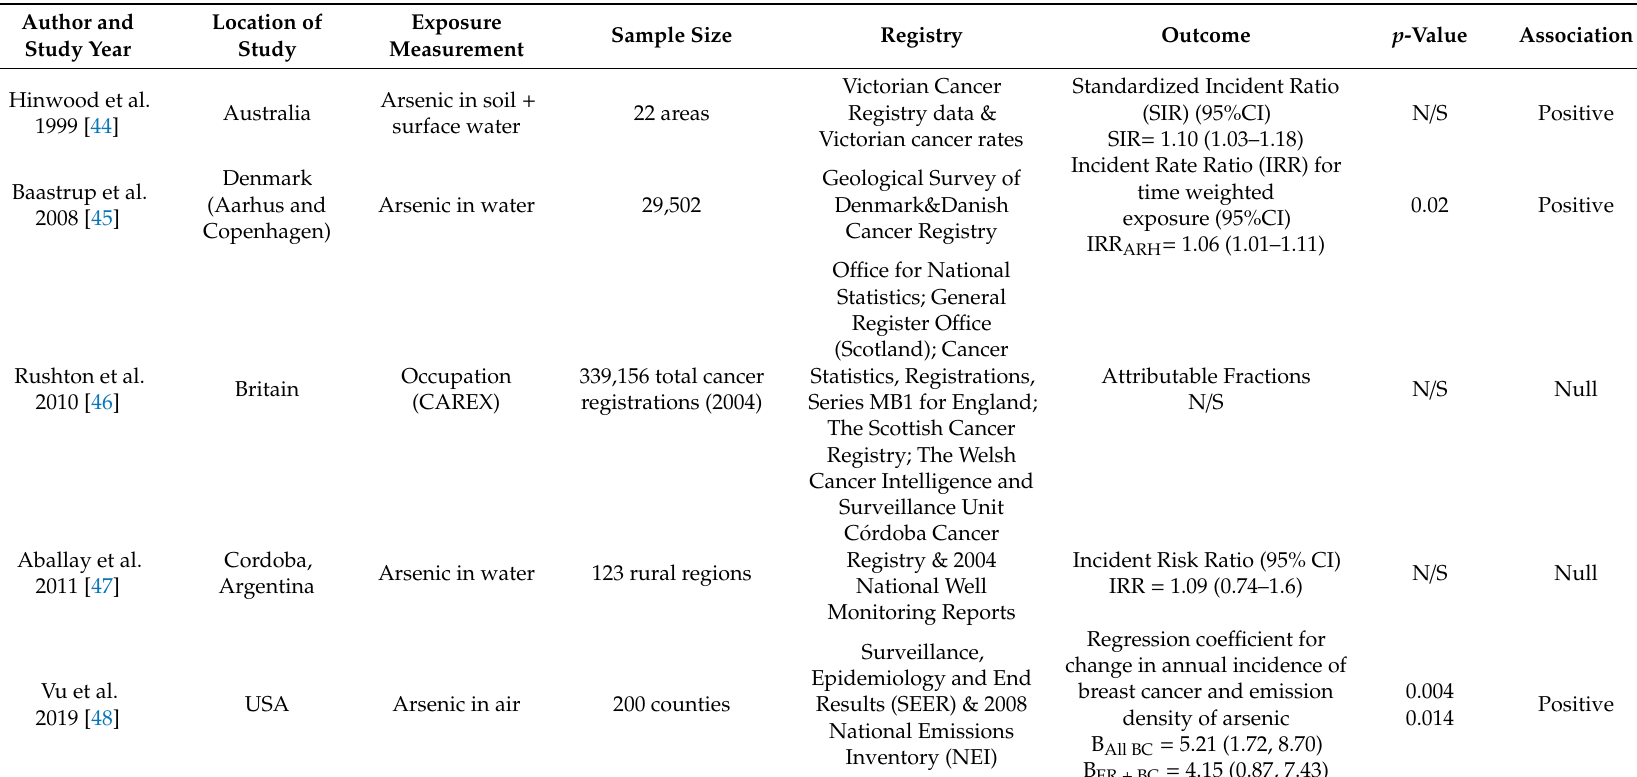
Table 2. Summary of ecologic studies investigating the relationship between arsenic exposure and breast cancer